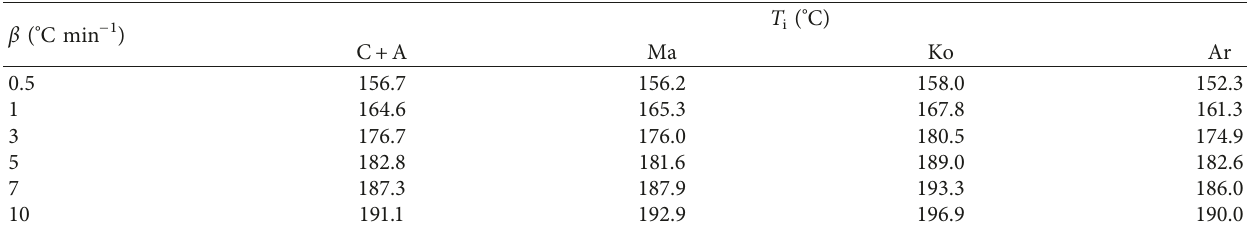
Figure 1: Nonisothermal DSC records of thermal oxidation (olive oil: C+A) obtained for different heating rates (from top to bottom: 0.5, 1, 3, 5, 7, and 10 ° Table 3: Oxidation onset temperatures of olive oils for various heating rates.